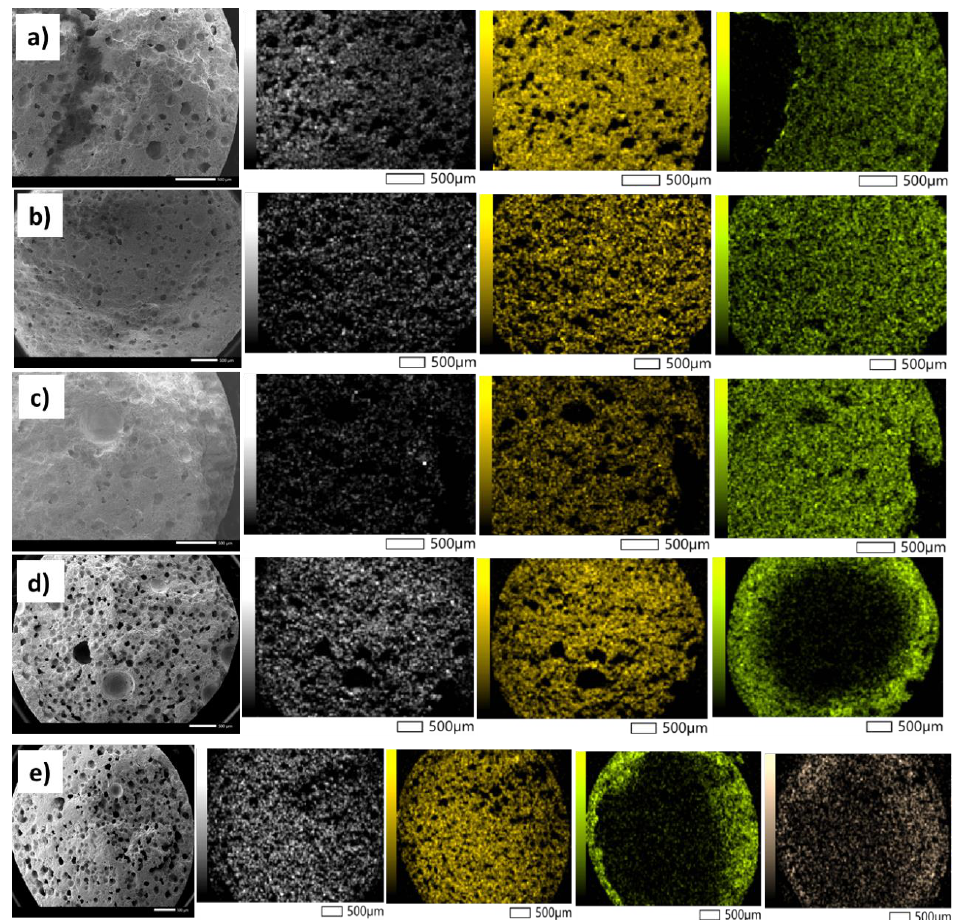
Figure 3. SEM-EDS elemental mapping of sodium (gray), potassium (yellow), cobalt (green) and manganese (brown) on cross section area of AA-S-Co ( a ), AA-N-Co ( b ), AA-D-Co ( c ), AA-IE-Co ( d ) and AA-IE-CoMn ( e ) catalysts.